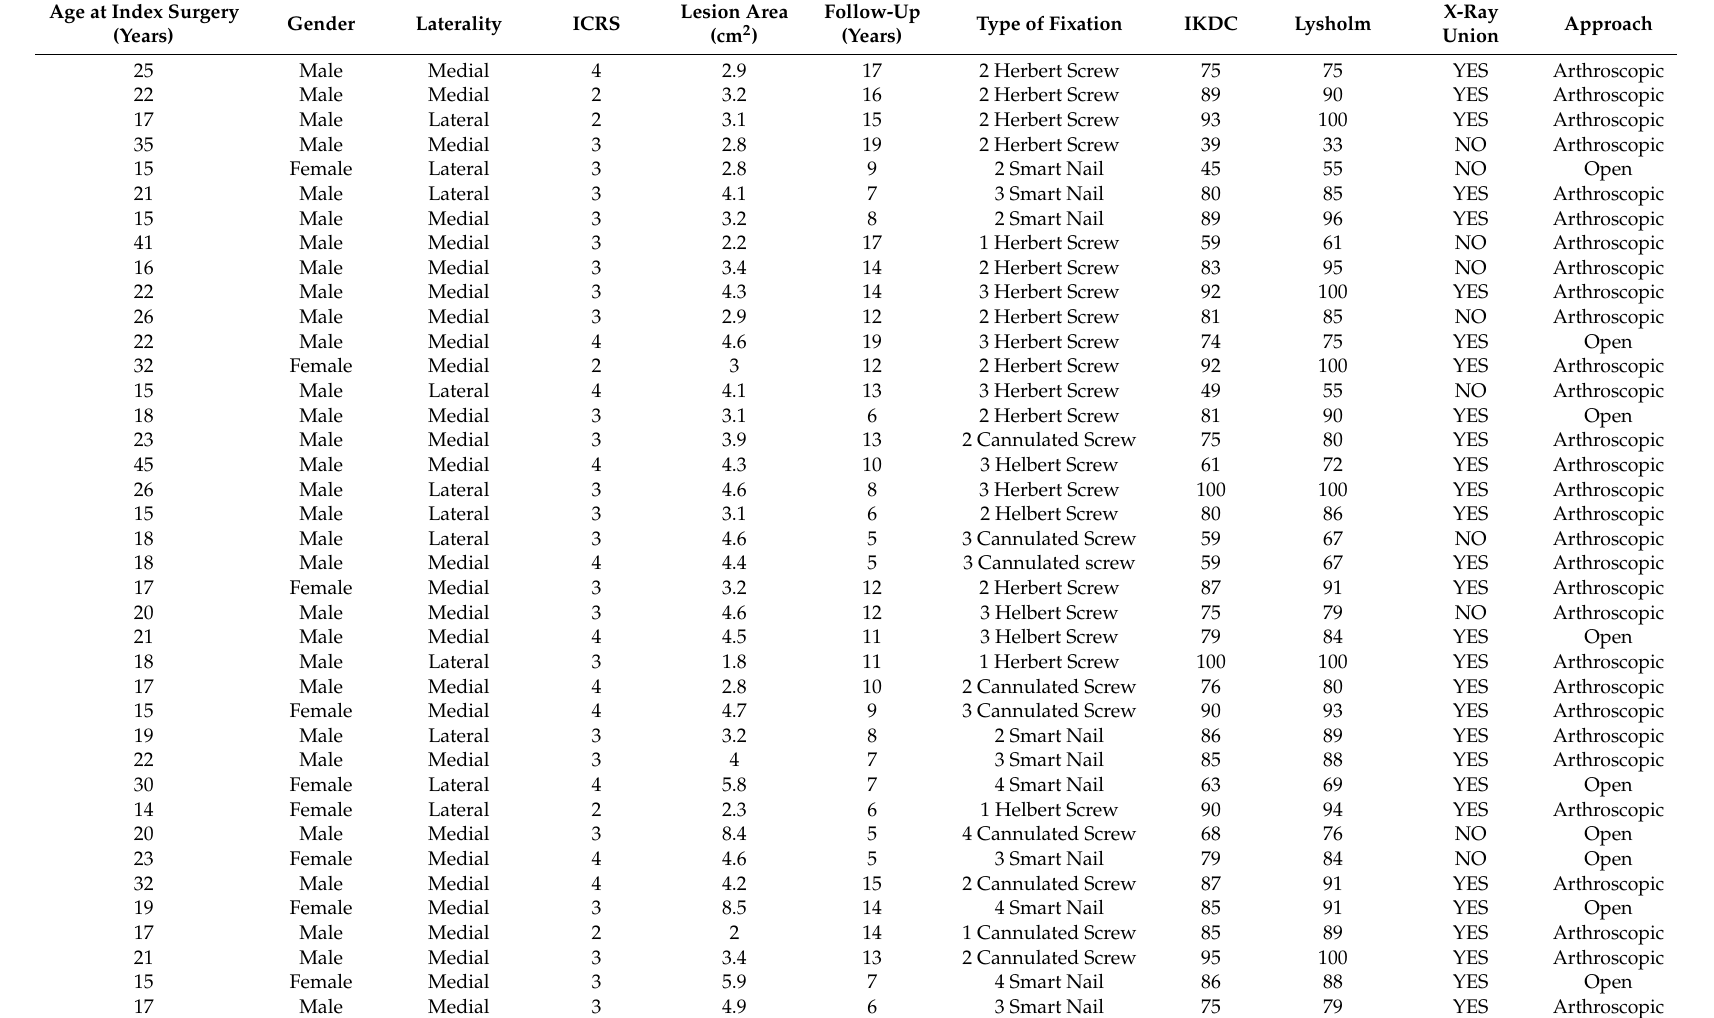
Table 1. Cross-sectional table demonstrating the relevant characteristics of the study